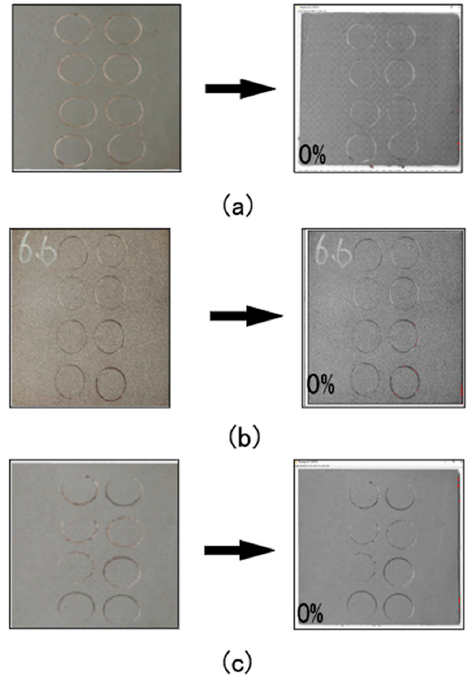
Figure 19. Corrosion of the with-zinc specimens with pavement air voids of ( a ) 2%, ( b ) 6%, and ( c ) 10% (Note: the red area represents the corrosion area).